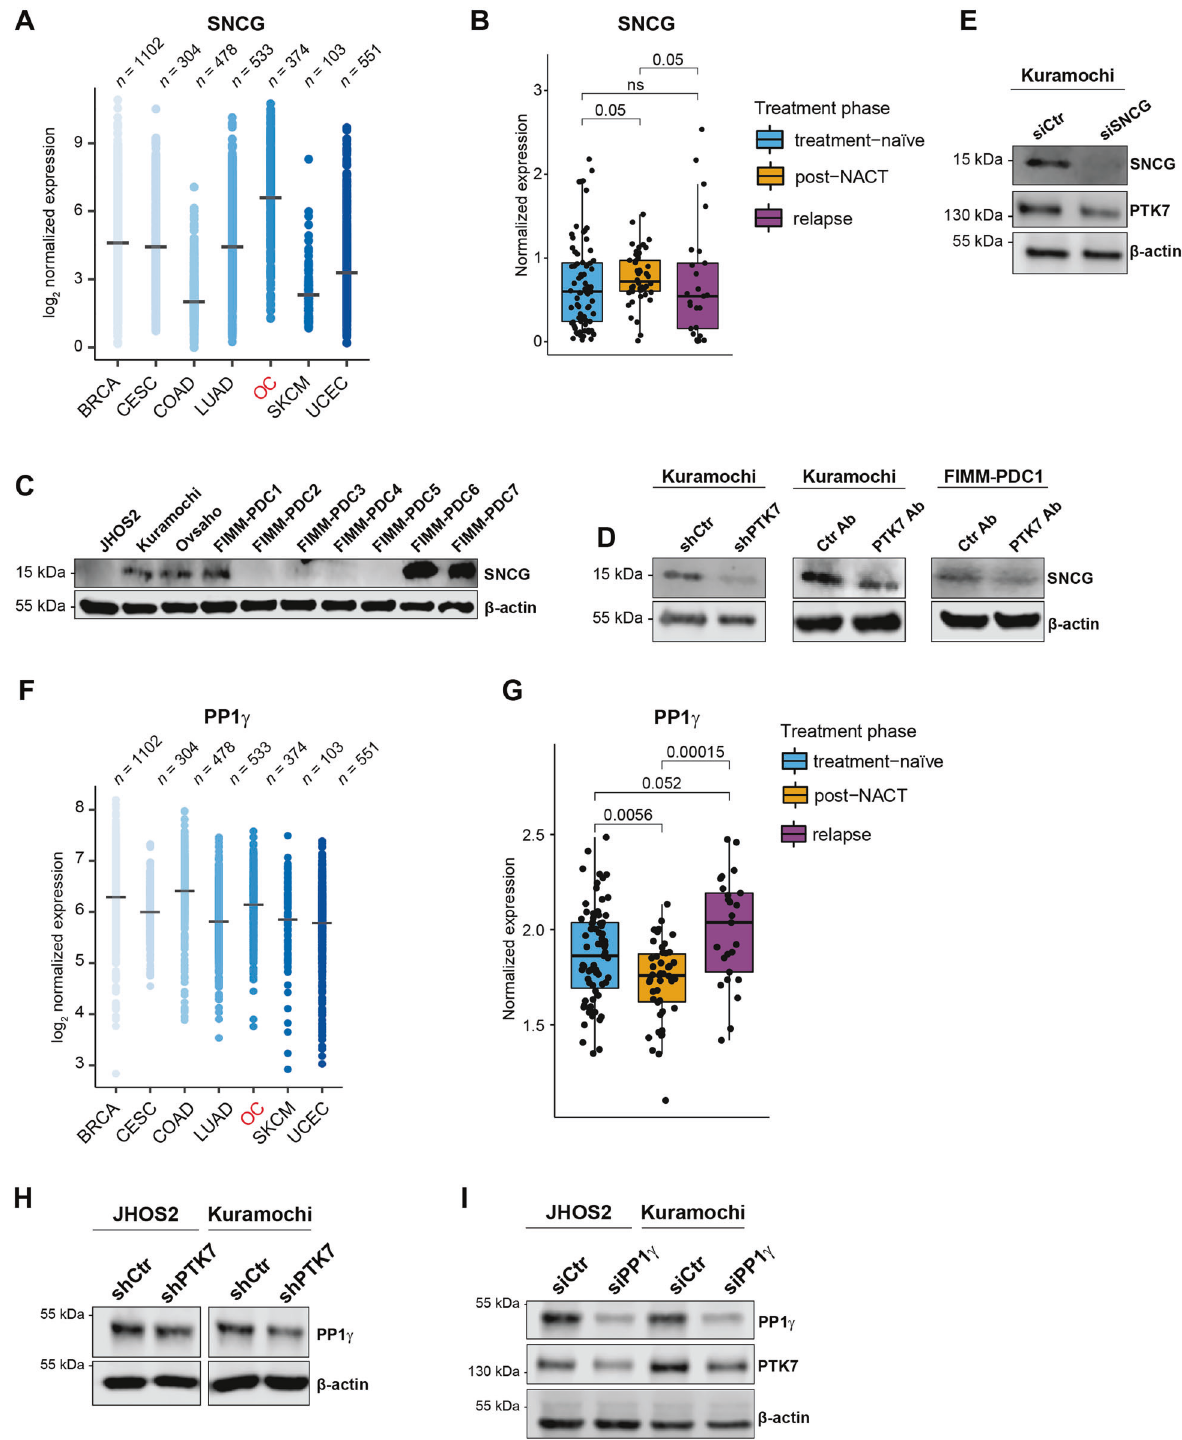
Supplementary Table 1) showed that PTK7 enriched with terms related to cell motility, adhesion, and migration. Terms related to MAPK, PI3K, and EGF/EGFR signaling were distinctively enriched with ROR1 and ROR2, but not with PTK7, whereas all three receptors were linked to Wnt5a and mTOR signaling modules (Fig.